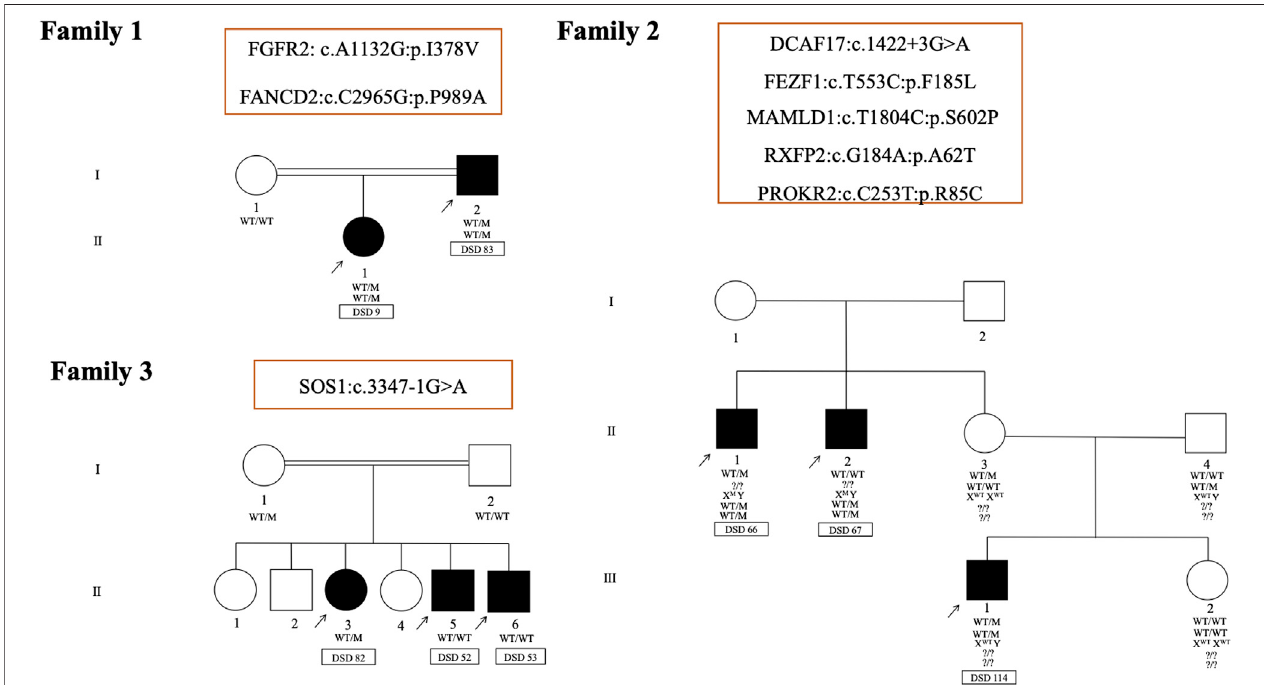
FIGURE 6 | Pedigrees and representative segregation of the curated variants in three unrelated families with 46, XY DSD. Family 1 includes DSD cases 9 and 83. Family 2 includes DSD cases 66, 67 and 114and family 3 includes DSD cases 52, 53 and 82. Genotypes of family members is indicated. Squares represent male family members and circles represent female family members. Solid squares represent affected 46, XY subjects who were raised as boys. Squares containing solid circles represent affected 46, XY subjects who were raised as girls.